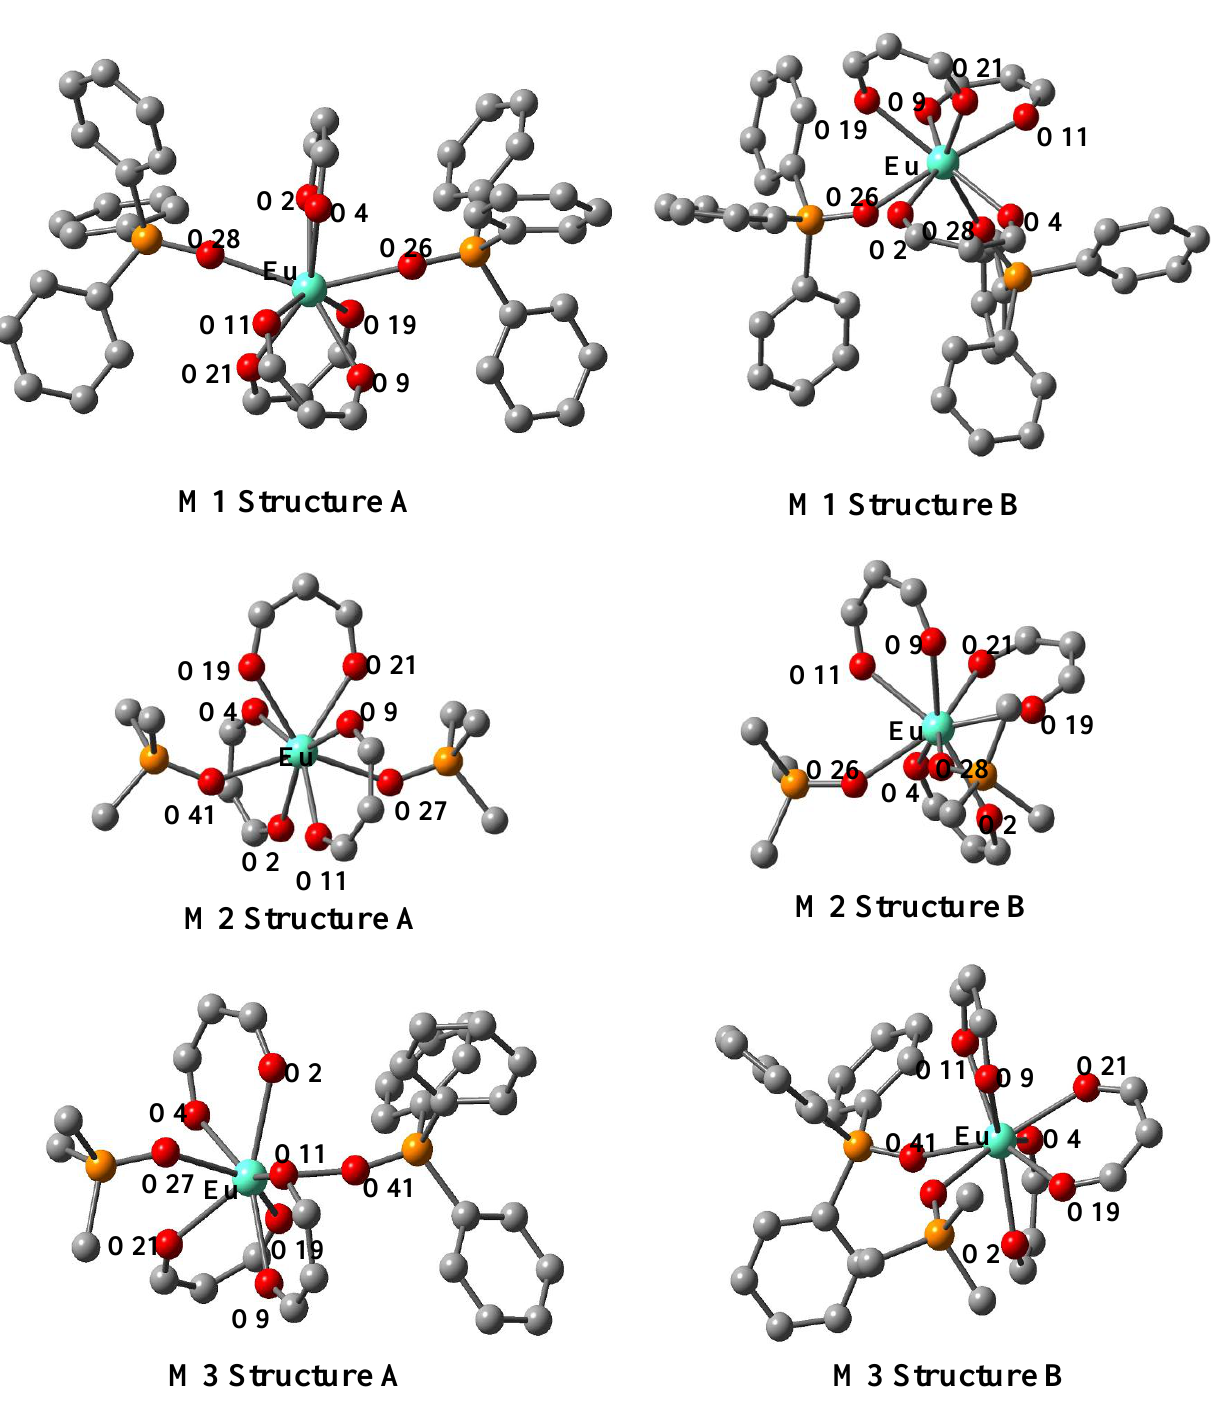
Figure 17. Two optimized geometries for Eu(III) complexes (structures A and B) in the molecular structure shown in Figure 1, M1: R 1 =R 2 =Ph, R 3 =R 4 =H; M2: R 1 =R 2